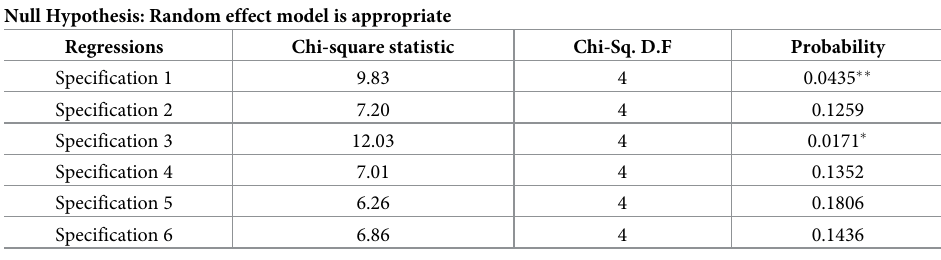
Table 2. Hausman test results for direct impact.